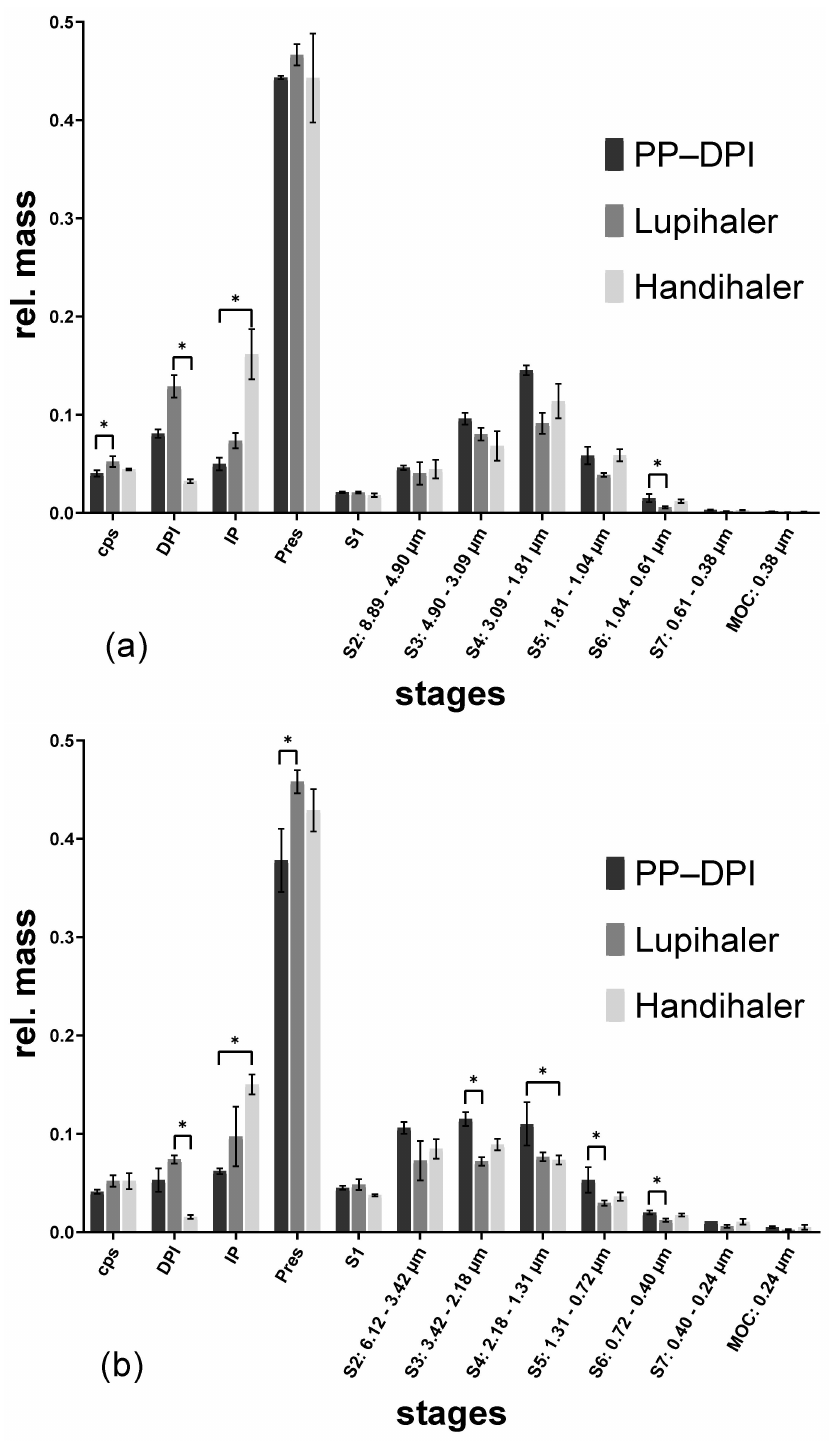
Figure 4. NGI results of the albuterol sulfate formulation actuated with different devices at different flow rates. ( a ) 50 L/min; ( b ) 100 L/min, (capsule = cps; dry powder inhaler = DPI; induction port = IP; preseparator = Pres), (* p <